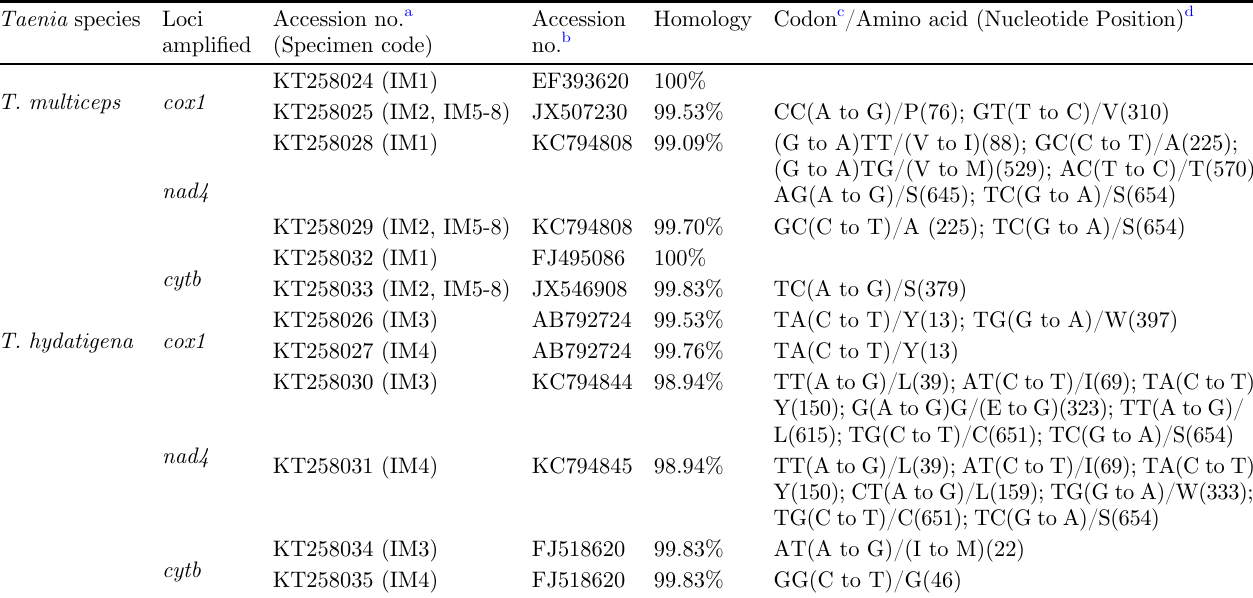
Table 2. Homology analysis of T. multiceps and T. hydatigena isolates at the three mitochondrial loci. Taenia species Loci Accession no. a (Specimen code) ampli fi ed